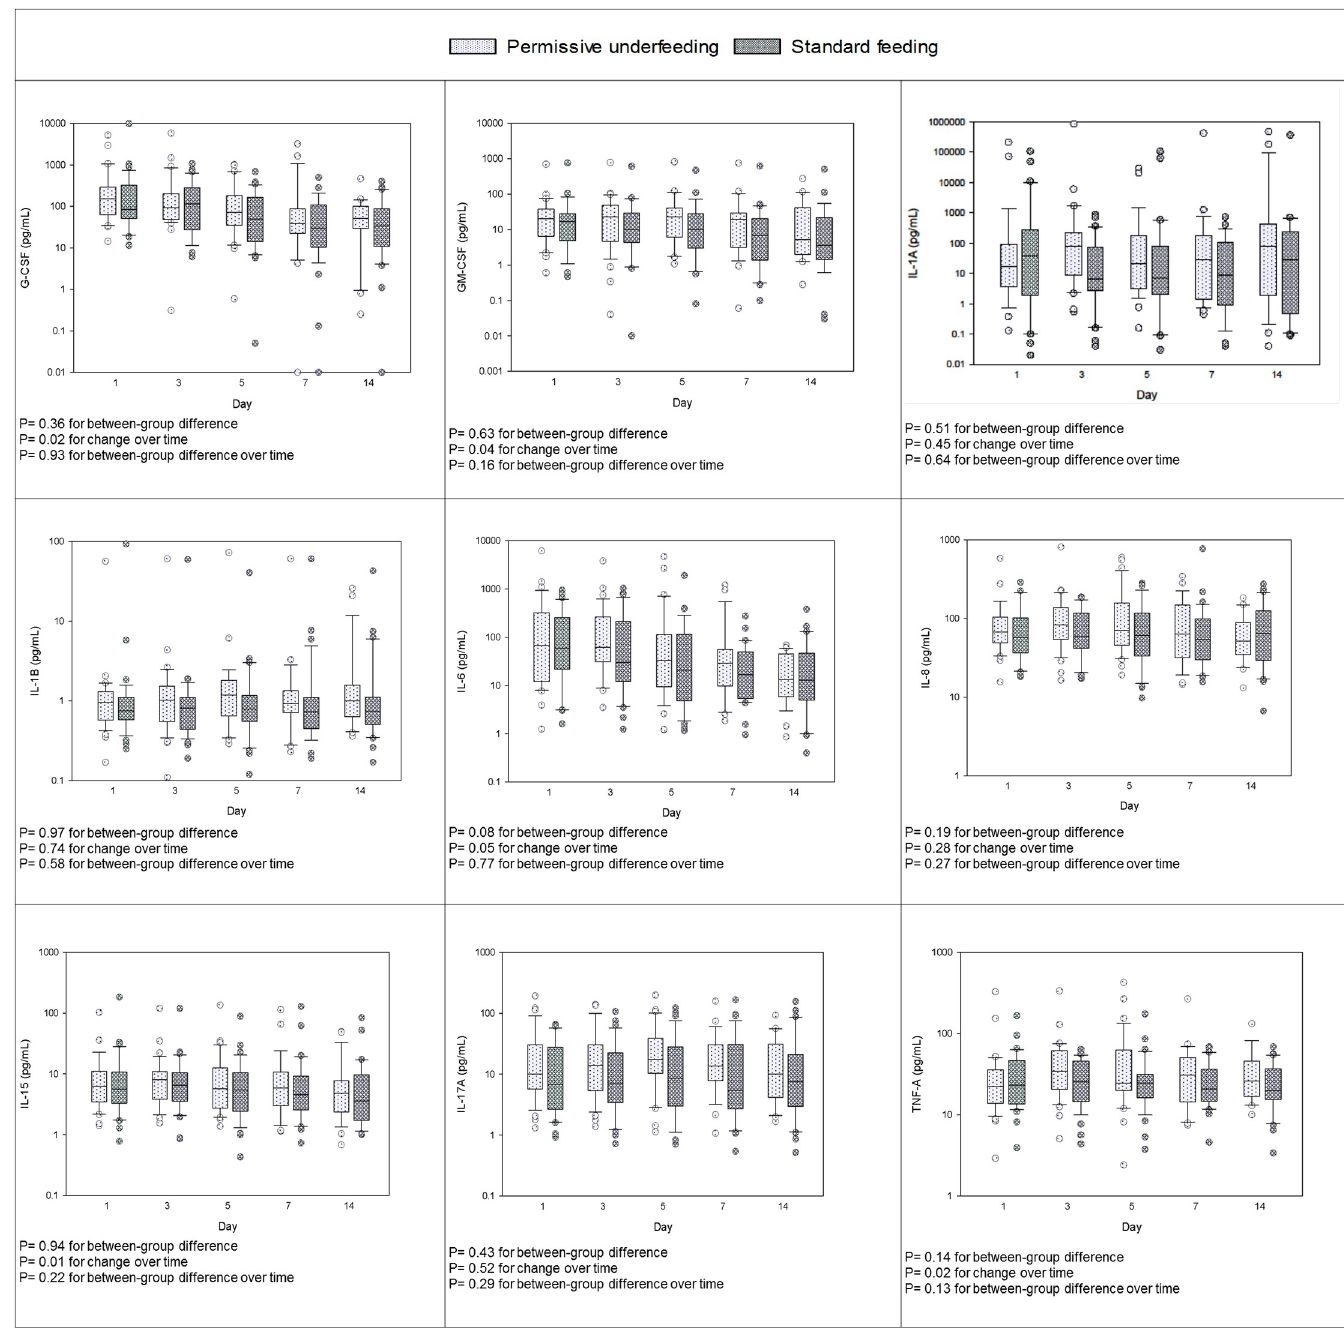
Fig 1. Serial measurements for selected acute pro-inflammatory cytokines in patients randomized to permissive underfeeding and standard feeding groups. The differences between groups, with time and between groups with time (group � time) were tested by repeated measures mixed linear models. Box plots are displayed with medians and quartiles 1 and 3. The error bars refer to 10 th and 90 th